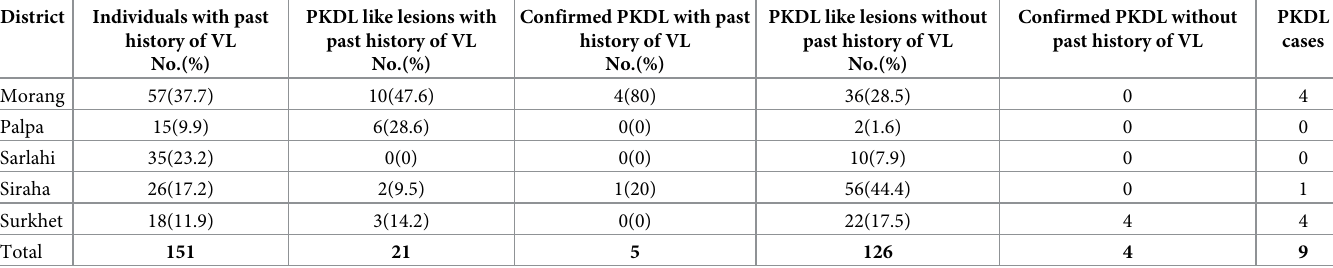
Table 2. Individuals with VL in the past and PKDL like skin lesions.